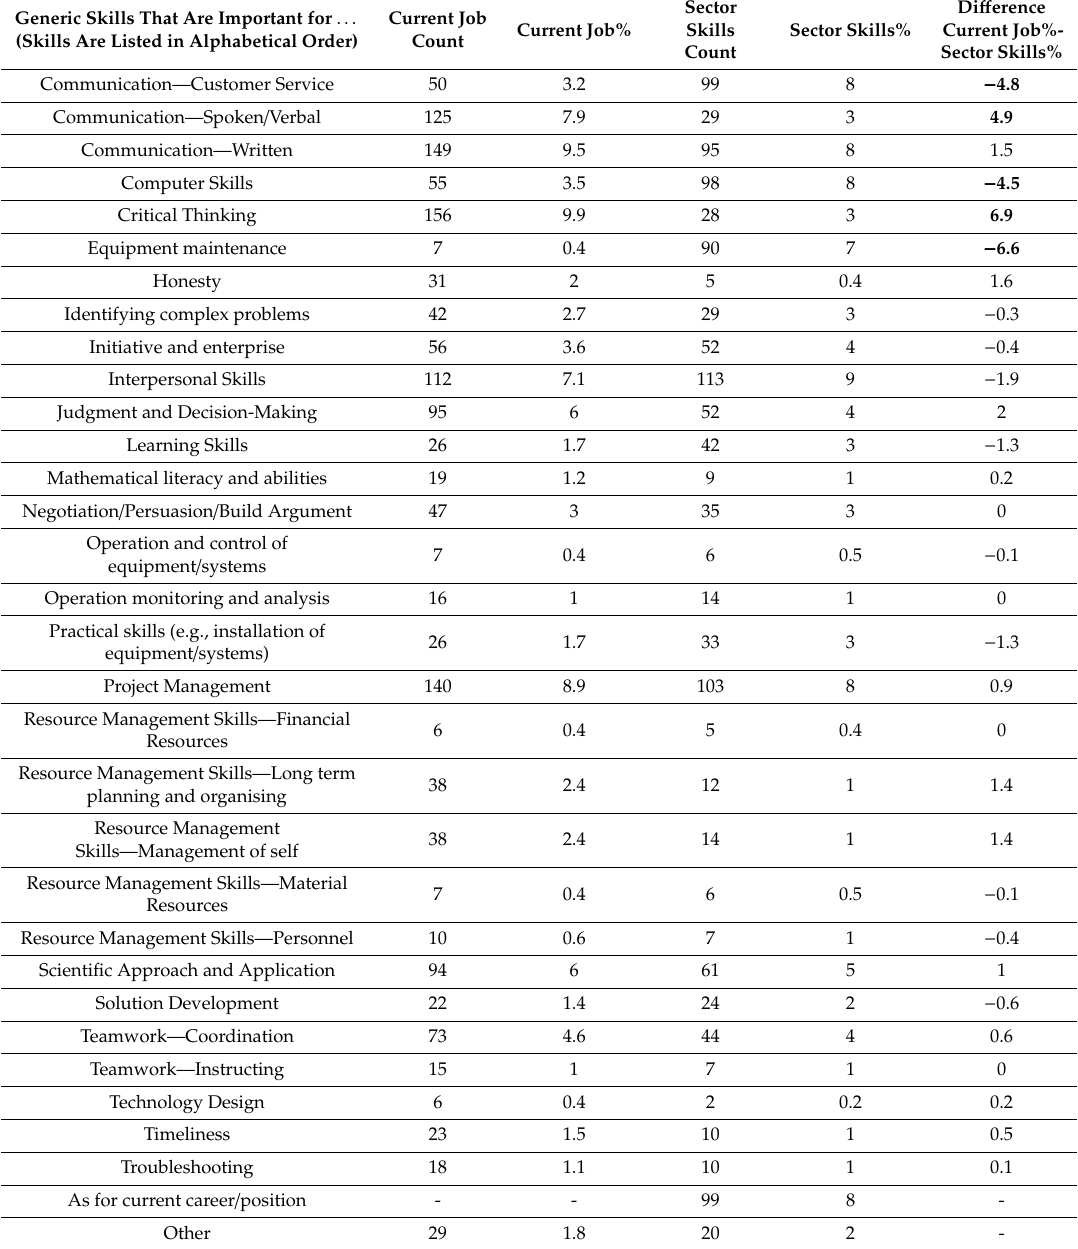
Table 1. Generic skills of importance for environmental professionals